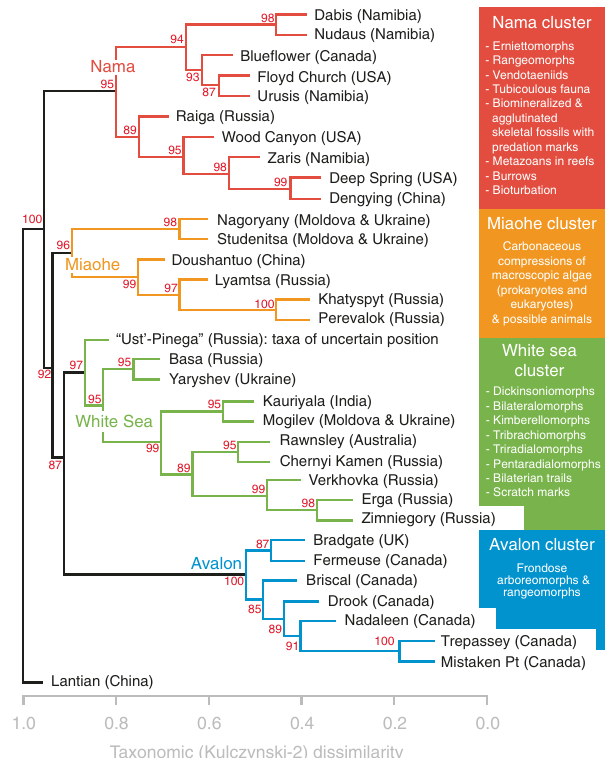
Fig. 1 Hierarchical clustering. Dendrogram of 34 geologic formations containing fi ve or more macrofossil genera and/or ichnogenera of Ediacaran age. Formations were clustered based on their taxonomic (Kulczynski-2) dissimilarities ( x -axis) using the average-linkage method. The high cophenetic correlation score of the dendrogram (0.8506276) — the correlation between observed taxonomic dissimilarities and those estimated via hierarchical clustering — indicates that the dendrogram faithfully preserves the pairwise distances between the original data points. Red numbers are approximately unbiased (AU) P -values calculated for nodes from 1000 multiscale bootstrap resamples. From bottom to top above the Lantian Formation, the labeled Avalon (blue), White Sea (green), Miaohe (orange), and Nama (red) clusters have AU P -values ≥ 0.95 and are supported by the data. Inset boxes are lists of the clusters ’ dominant fossils. The “ Ust ’ -Pinega ” formation encompasses occurrences of taxa that belong to the Lyamtsa, Verkhovka, and Zimniegory formations but have uncertain stratigraphic positions. See Supplementary Information for Jaccard dissimilarity results (Supplementary Fig. 2). Source data are provided as a Source Data fi